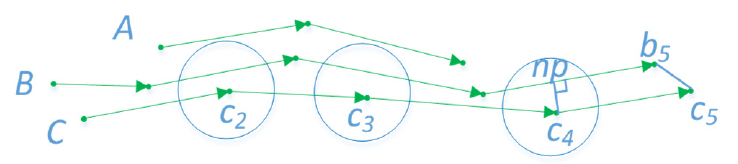
Figure 5. A , B and C are three trajectories, they are composed by several line segments and sample points. The green arrows represent the direction of the line segments, the green dots represent the sample points. Under the LCSS measure, A and B are similar, while B and C are dissimilar. The value of L is unbounded and depends on the length of the compared sequences.